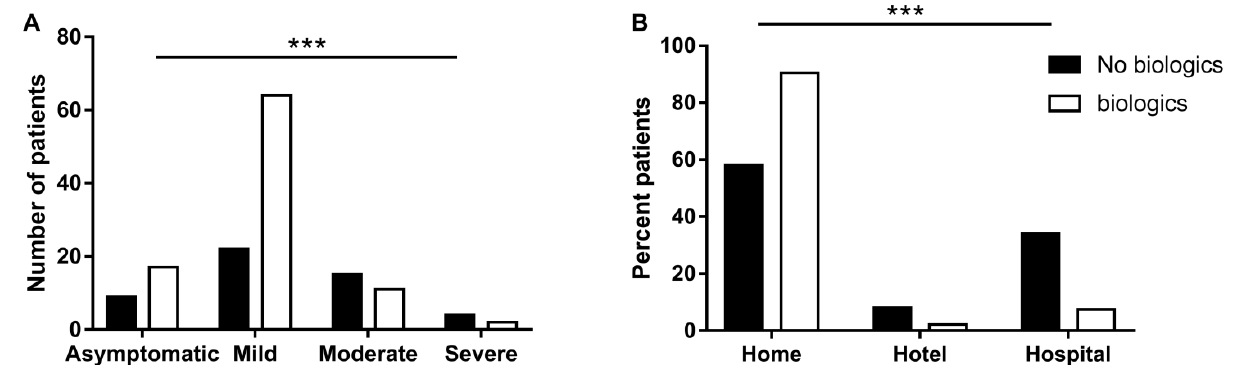
Figure 1. Association between IBD treatment and COVID-19 severity. ( A ) Number of IBD patients with various degrees of COVID-19 severity comparing biological therapy and non-biological therapy. ( B ) Outcome of COVID-19 in patients with IBD, comparing biological therapy and non-biological therapy. The p -value is based on a Pearson Chi-square test comparing patient distribution between groups (biological therapy and non-biological therapy), with p < 0.001 (***) in all degrees of COVID-19 severity and outcomes.